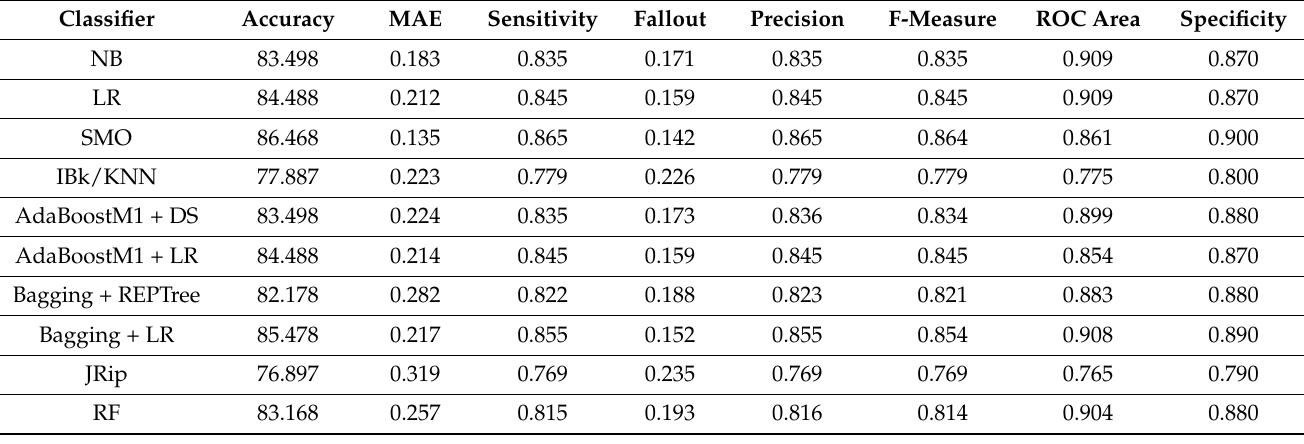
Table 9. Performance of the machine learning classifiers based on the optimum attribute set found using the chi-squared attribute evaluation technique.